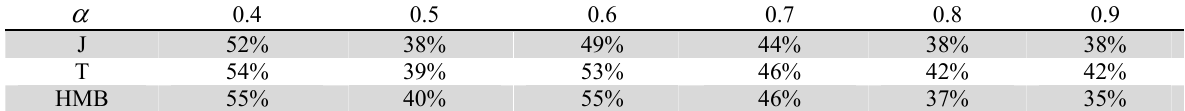
Comparison of the IM for variable variance base on  in constant variance mode (The number of machines = 2, The number of Jobs = 10, Means 130-170, Variance =